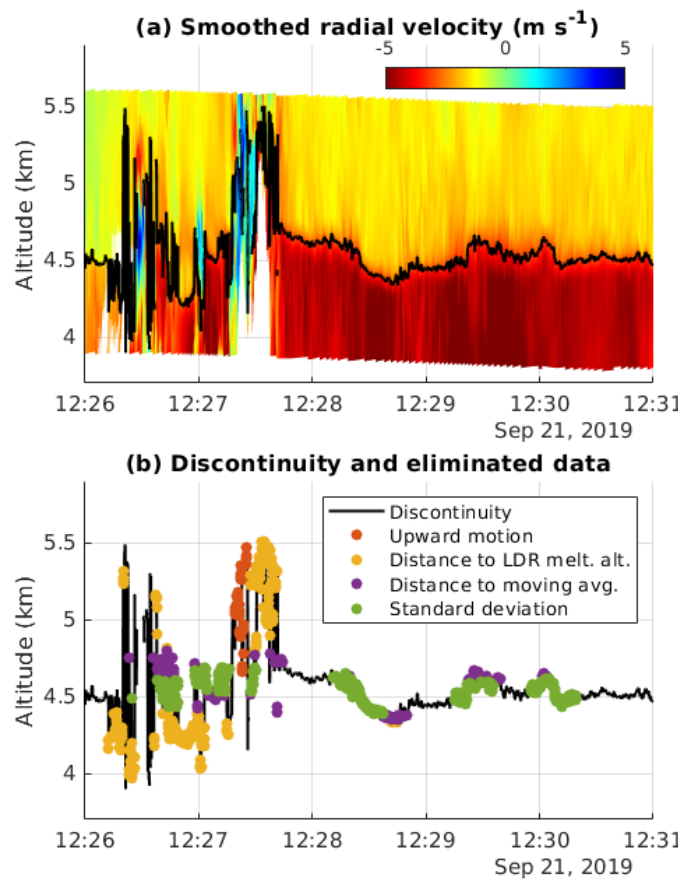
Figure 2. ( a ) Smoothed radial velocity (color shading) and detected discontinuity (black line). ( b ) Discontinuity (black line). Color dots indicate results that were removed for the following reasons: red—upward motion was detected; yellow—the distance to the melting layer altitude detected in LDR exceeds 200 m; purple—the distance between the raw result and the 100 s moving average exceeds 100 m; green—the 30 s standard deviation exceeds 35 m. Times are in UTC.